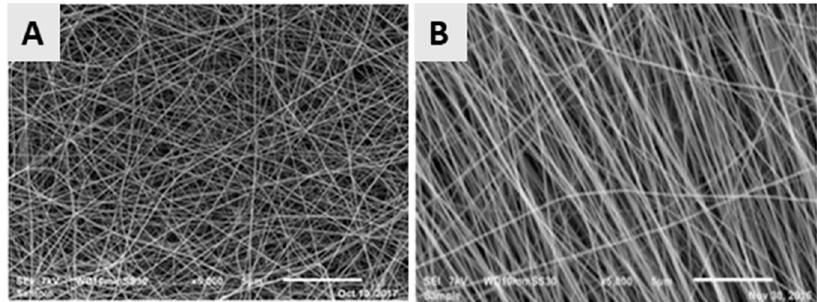
Figure 8. SEM images of the poly- ε -caprolactone (PCL) ( A ) Random nanofibers; collector speed: 300 rpm—Reproduced with permission from [106]. American Chemical society, 2018 and ( B ) aligned nanofibers; collector speed: 3000 rpm (for both images: concentration = 14%, mixture of formic and acetic acid (9:1), voltage: 32–33 kV)—reproduced with permission from [119] . Copyright Elseivier, 2018.